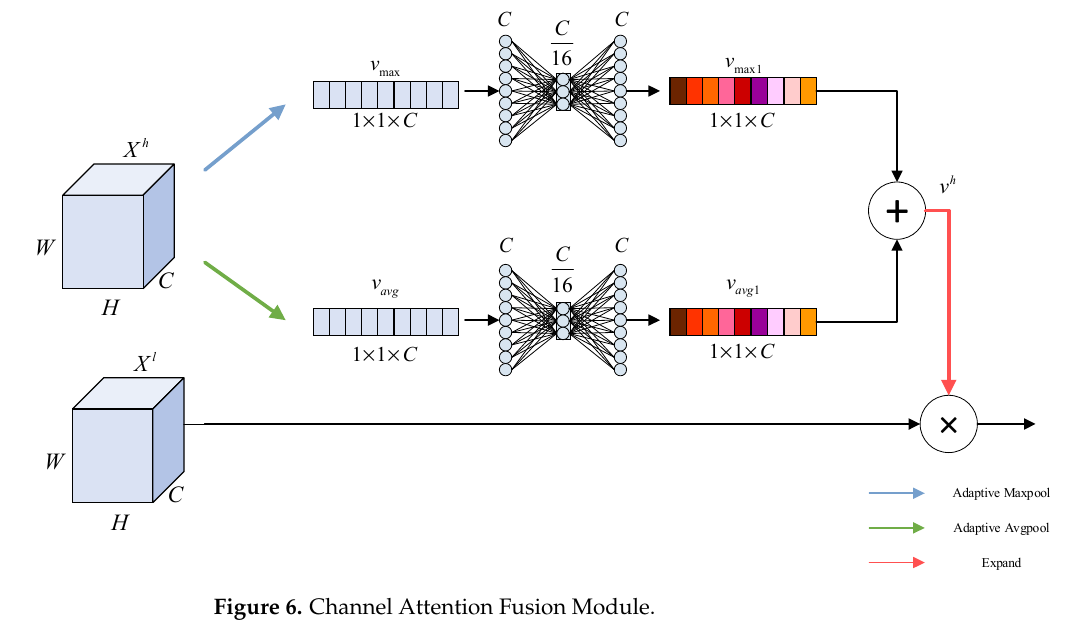
Figure 6. Channel Attention Fusion Module.